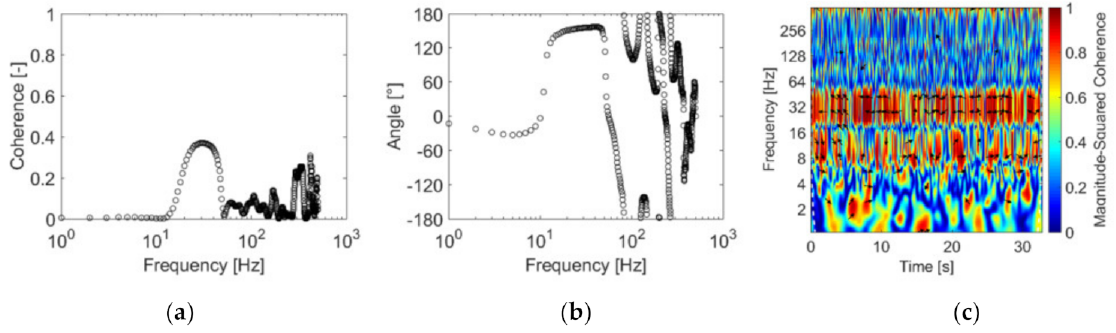
Figure 11. ( a ) Cross-coherence between acceleration signals from both cylinders free to vibrate for reduced velocity equal to 46, ( b ) phase angle obtained in the cross-coherence, and ( c ) wavelet coherence between acceleration from the first cylinder and the second cylinders free to vibrate for reduced velocity equal to